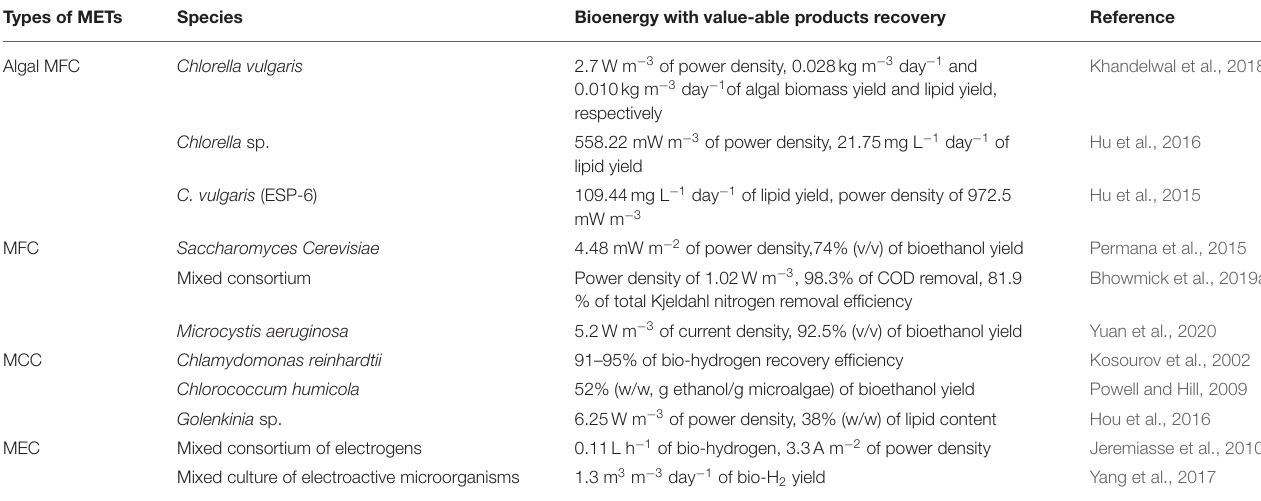
TABLE 3 | Bioenergy production and other value-added products recovery through METs. Types of METs Bioenergy with value-able products